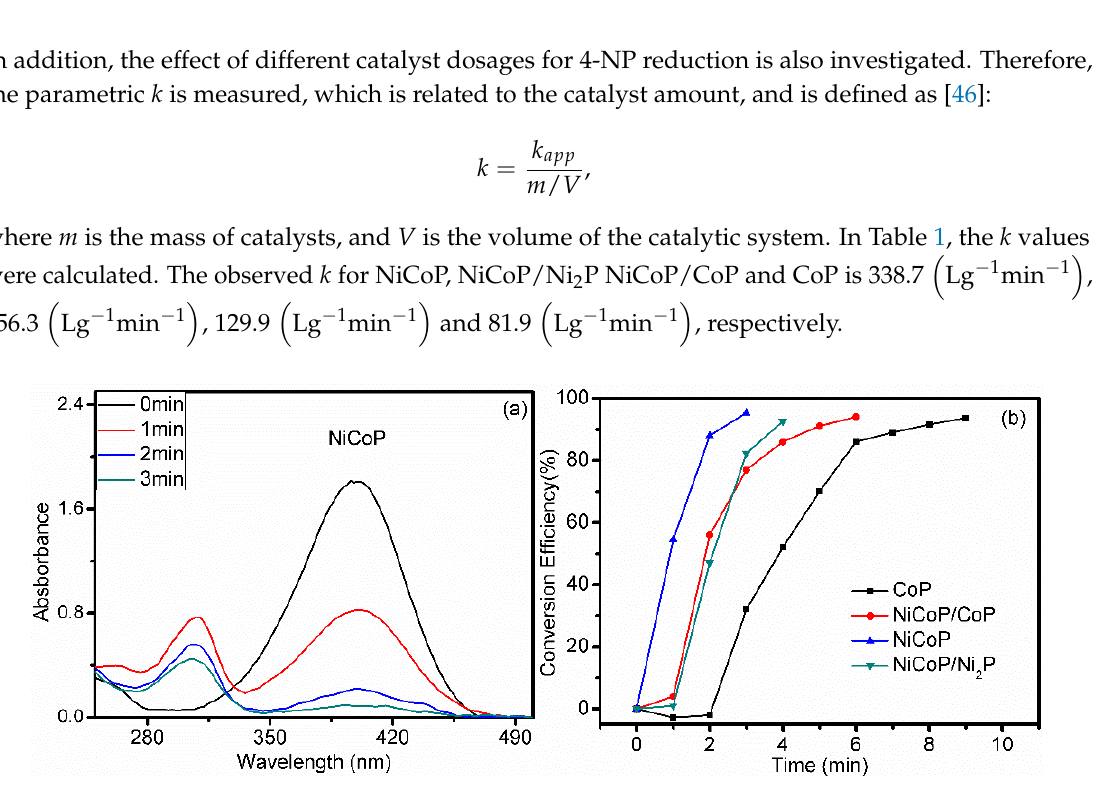
Figure 8. ( a ) UV–Vis spectra of 4-NP catalyzed in presence of NiCoP at different time. ( b ) The relationships between reduction efficiency of 4-NP and reaction time in the present of CoP, NiCoP/CoP, NiCoP and NiCoP/Ni 2 P, respectively.